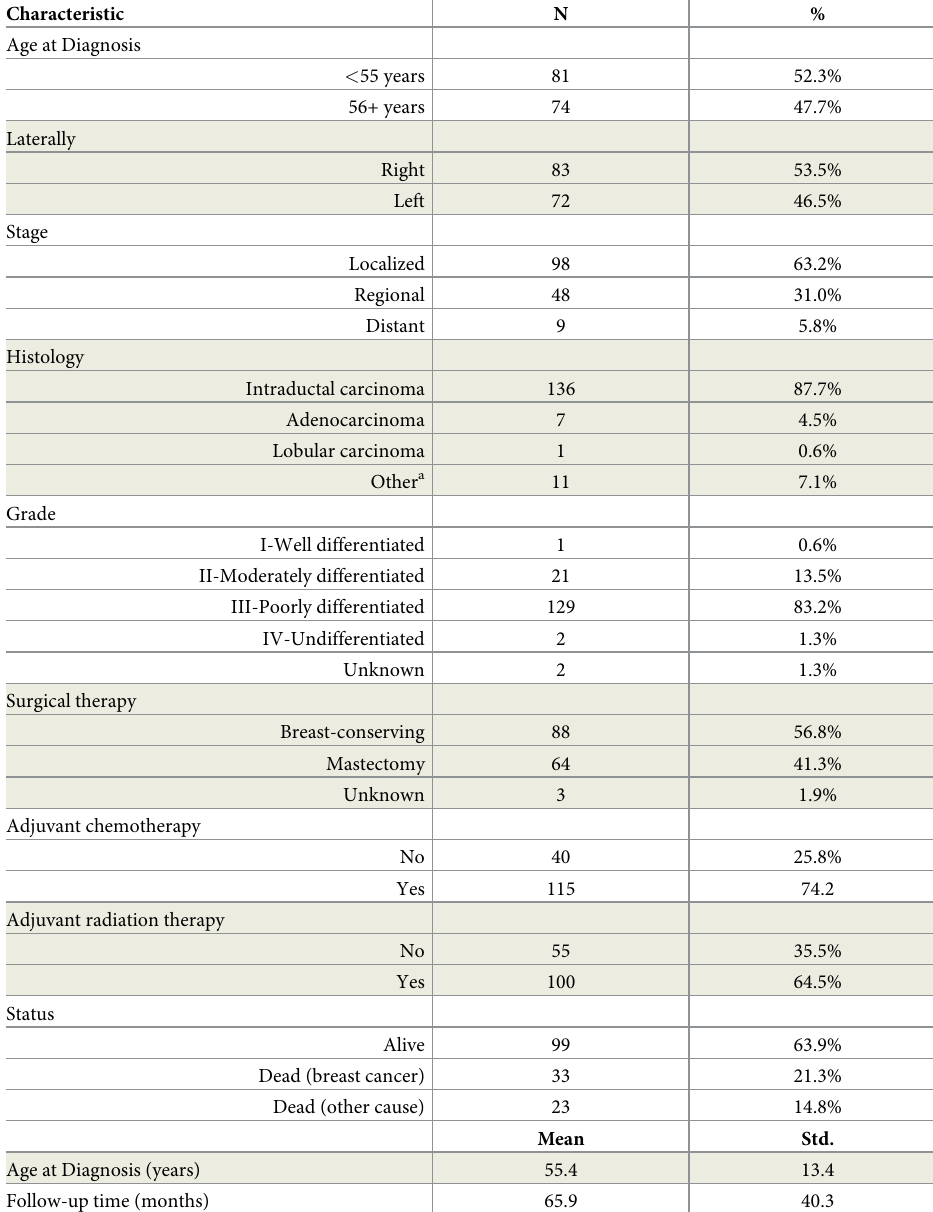
Table 1. Patient characteristics of 155 treatment-na ï ve TN tumors in the Detroit AA cohort.